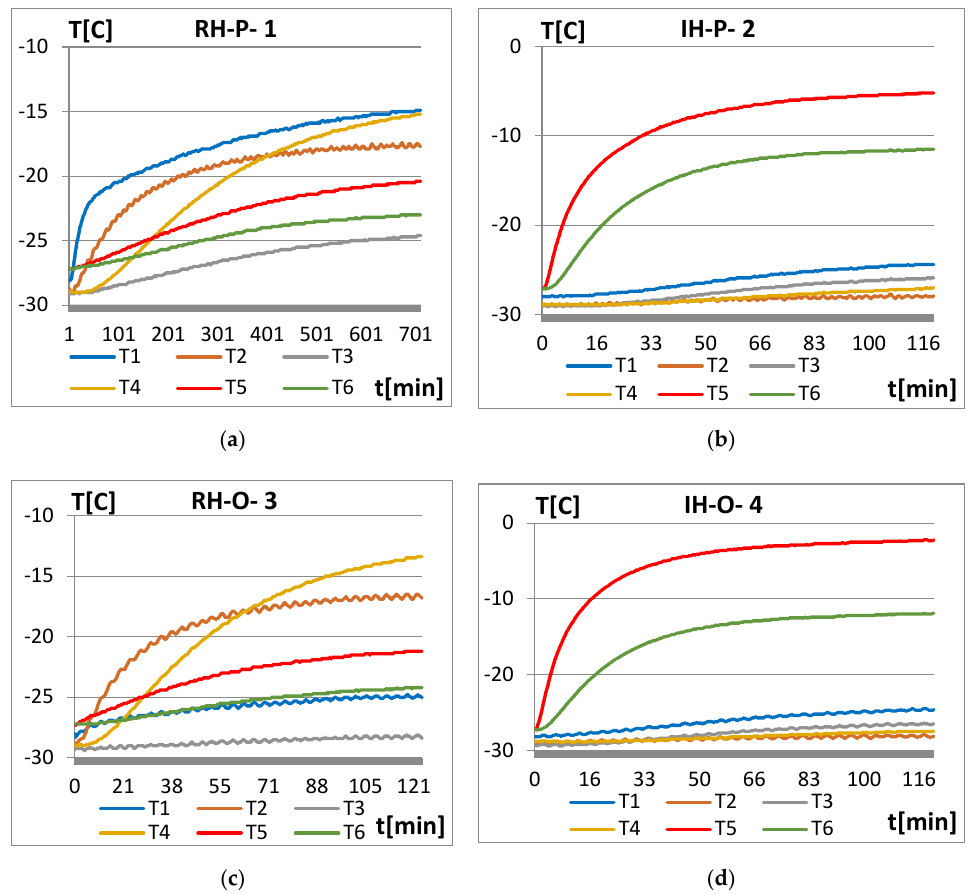
Figure 18. Temperature distribution across a turnout for ambient temperature – 30 °C at the points: T1 — on the switch-rail foot, T2 — on the stock-rail foot, T3 — on the switch-rail head, T4 — on the stock-rail head, T5 — in the slide plate part to the side of the stock-rail, T6 — in the slide plate part to the side of the switch-rail; ( a ) resistance heating, the switch-rail touching; ( b ) induction heating, the switch-rail touching; ( c ) resistance heating, the switch-rail away; and ( d ) induction heating, the switch-rail away.